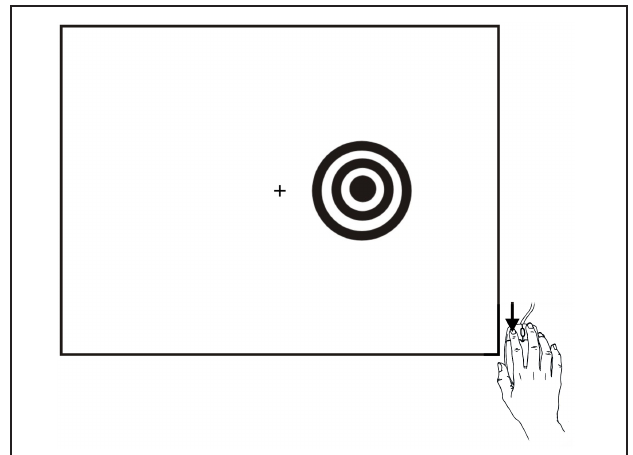
FIGURE 1 | Stimuli and task. Stimuli were high-contrast bulls eyes presented to the left or right hemifield for a duration of 200 ms at randomized stimulus onset asynchronies (SOAs) that ranged from 1000 to 1800 ms in five 200 ms steps in Experiment 1, and from 1000 to 2000 ms in five 250 ms steps in Experiment 2. Stimuli could occur in the visual hemifield ipsilateral (shown) or contralateral to the responding hand. Subjects responded to all stimuli as rapidly as possible by depressing the mouse button with the index finger of their dominant hand (i.e., right-handed subjects depressed the left mouse button and left headed subjects depressed the right mouse